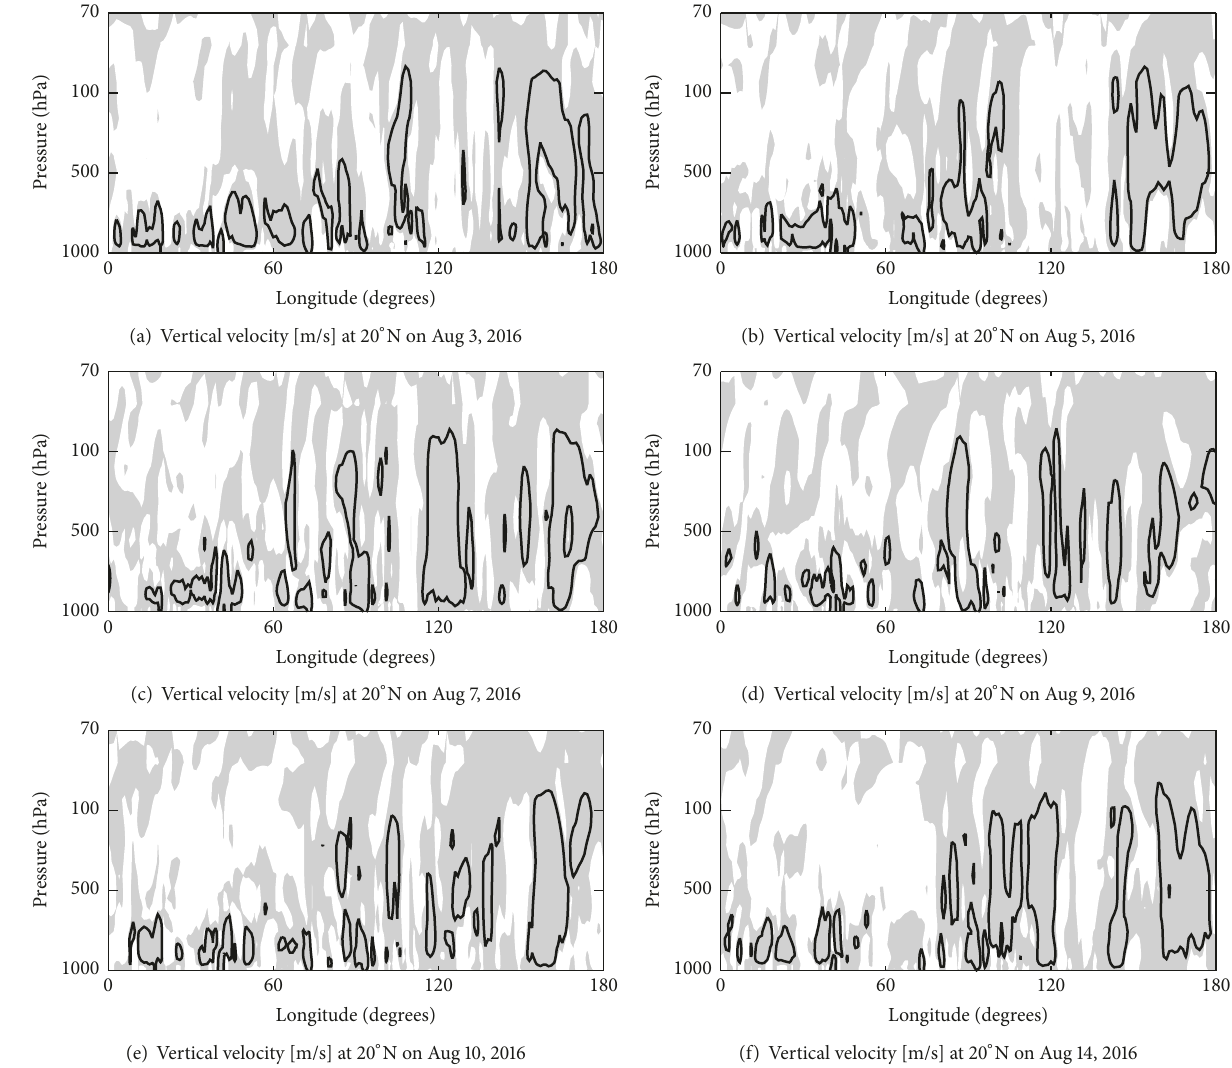
Figure 7: A pressure-longitude cross section of vertical velocity along 20 ∘ N on (a) Aug 3, (b) Aug 5, (c) Aug 7, (d) Aug 9, (e) Aug 10, and (f) Aug 14, 2016. Gray shading regions indicate upward. Regions within black contours are strong upward motion regions (contour level is −